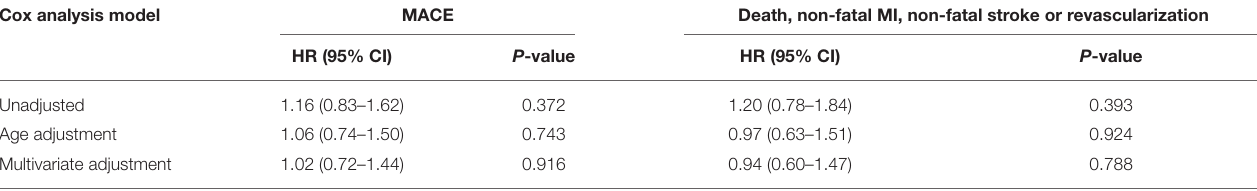
TABLE 3 | Association between gender and outcomes in